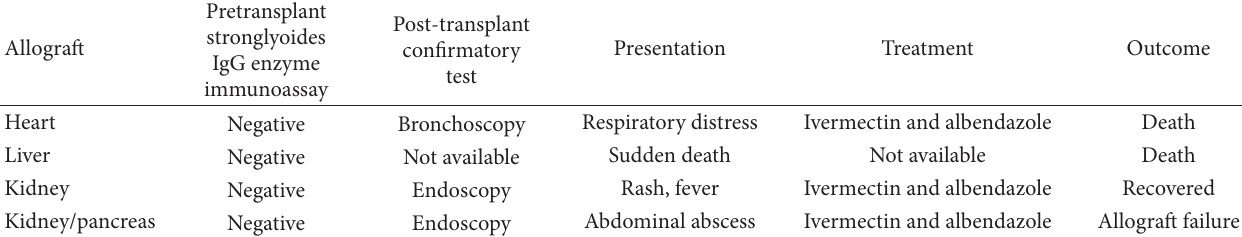
Table 1: Allograft recipient posttransplant Strongyloides confirmation.